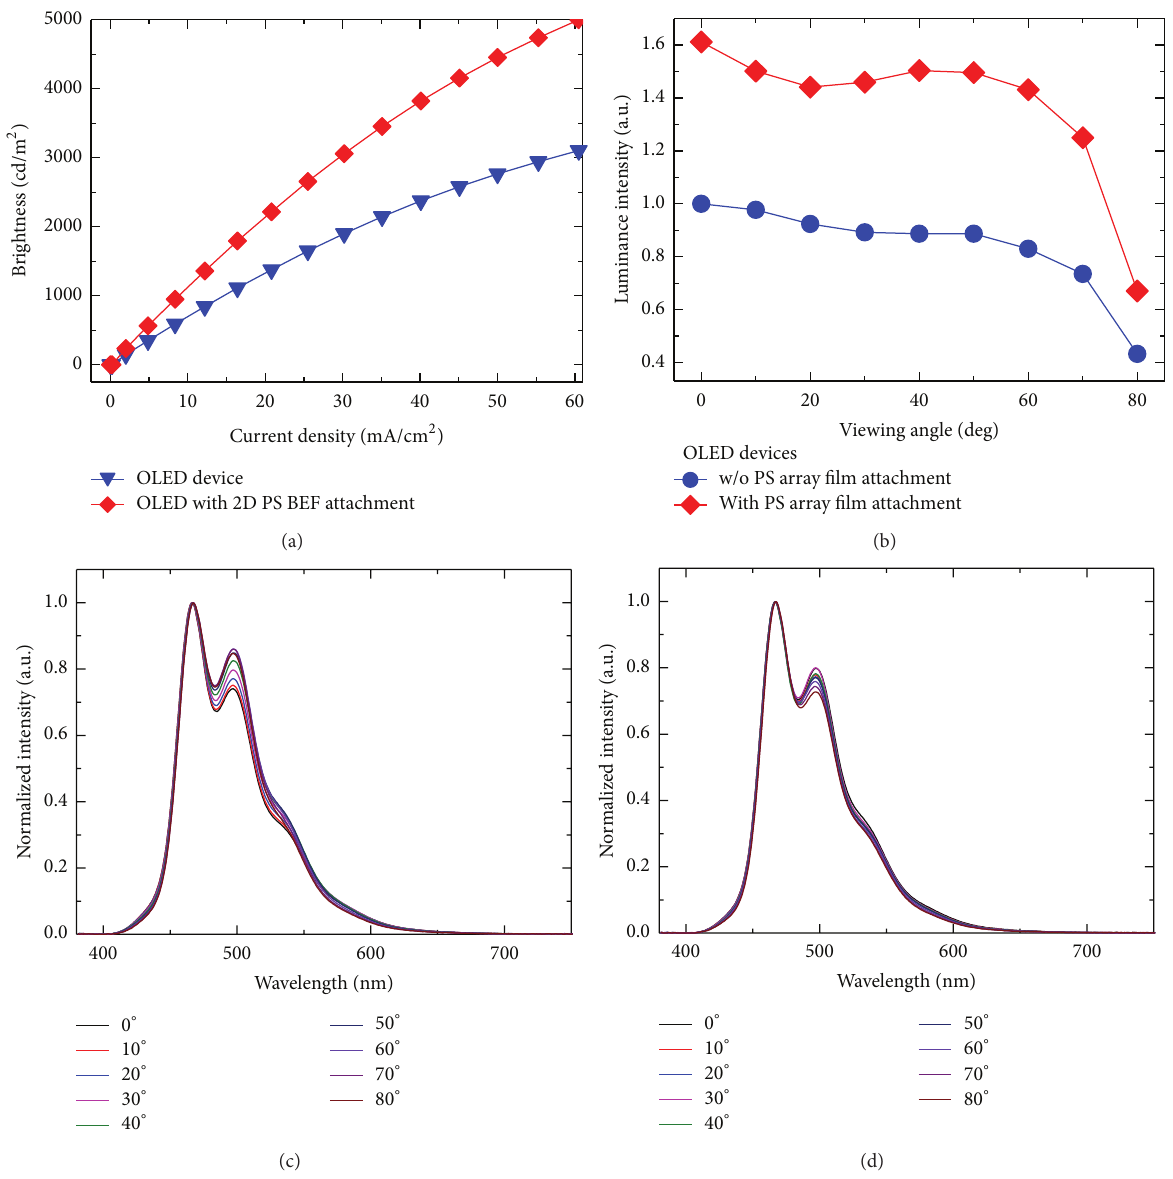
Figure 6: (a) Luminance versus current density and (b) the luminous intensity as a function of viewing angle for the OLED device with and without PS patterned BEF attachment. The EL spectrum for the OLED device (c) without and (d) with attaching 2D PS array patterned films (diameter: